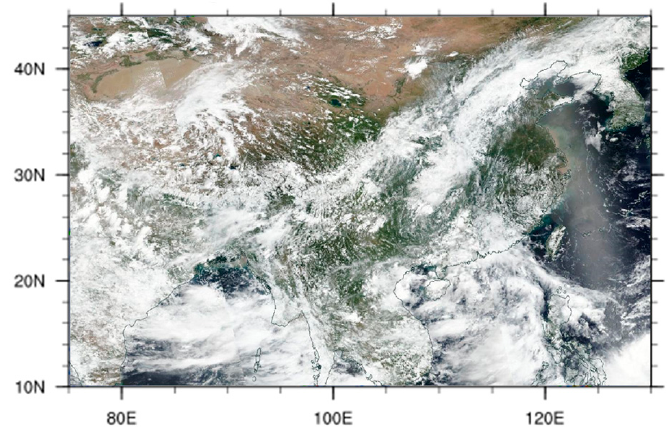
Figure 8. Cloud images from the VIIRS onboard